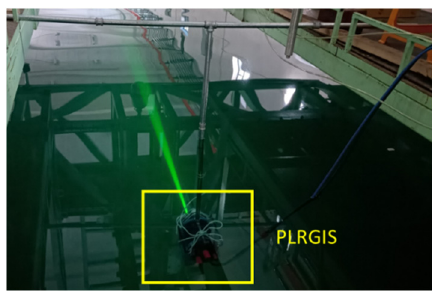
Figure 7. Component of PLRGI equipment. ( a ) Principle of the system; ( b ) Front view of the system. Experiments are carried out in a boat tank, which size is 175 m × 6 m × 4 m (length × width × depth). The wall of the boat tank is rough and the reflectivity of light is low. The PLRGI system is placed at 1m underwater as shown in Figure 8.